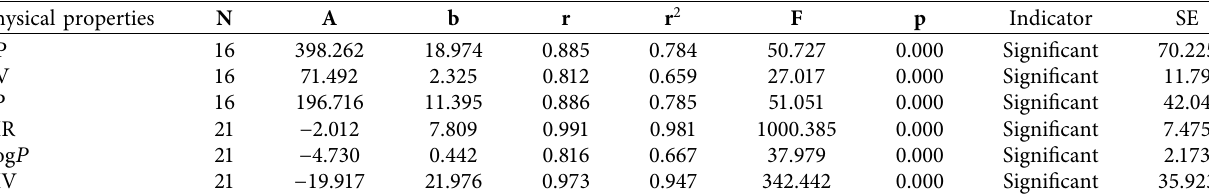
Table 5: Statistical specifications for the linear model of R ( G ) .